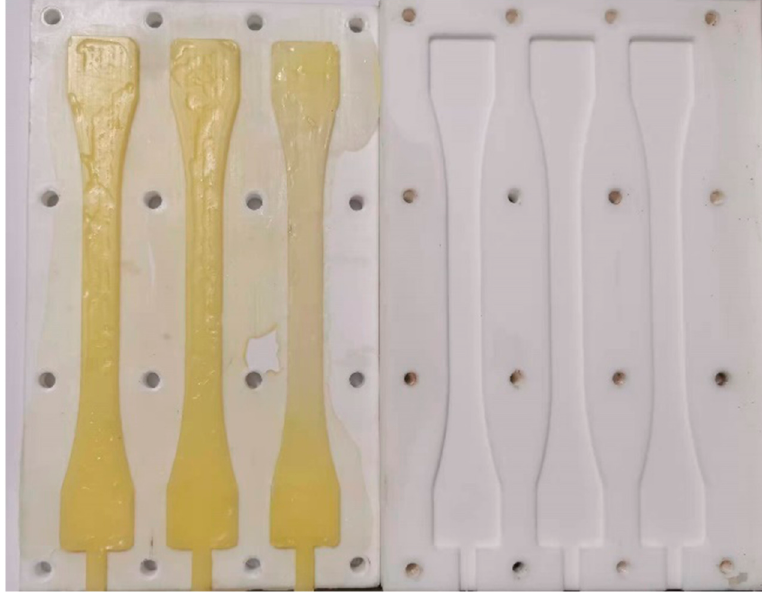
Figure 3. Mould for making dumbbell specimen.